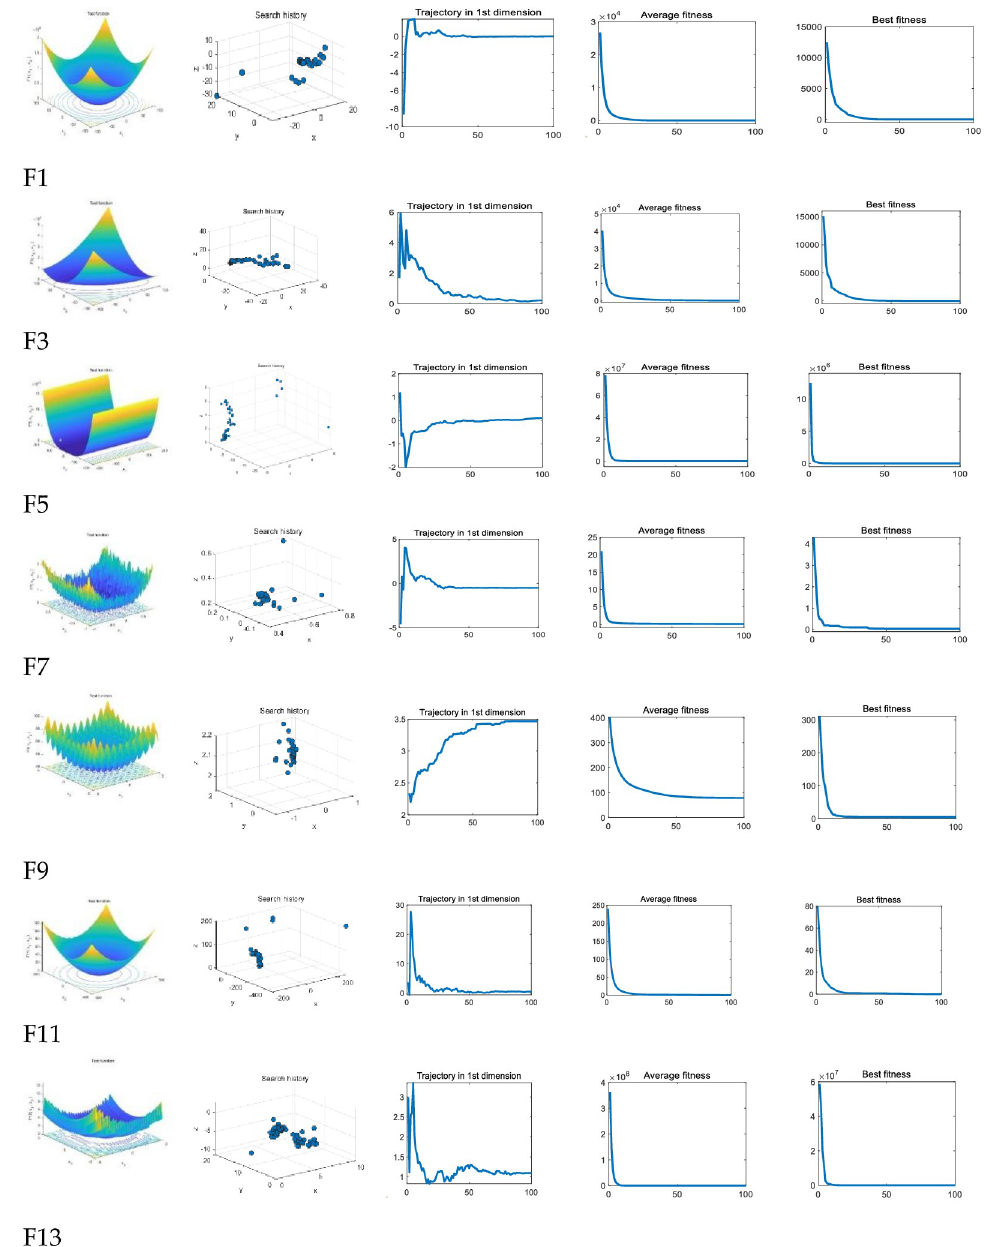
Fig 6. MSA search history of unimodal and multi-modal benchmark